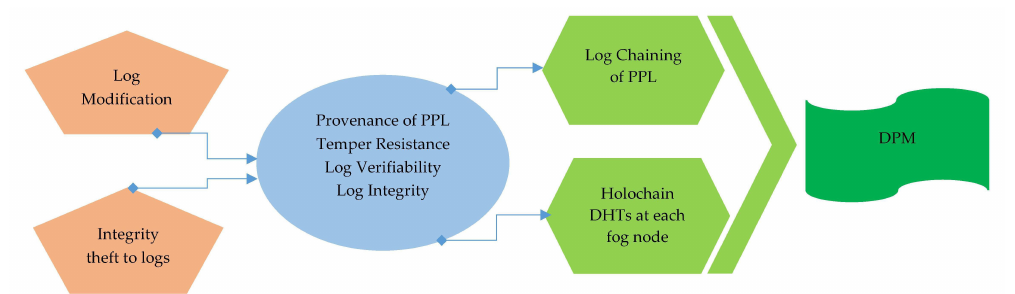
Figure 5. Log integrity and modification threats modelling.